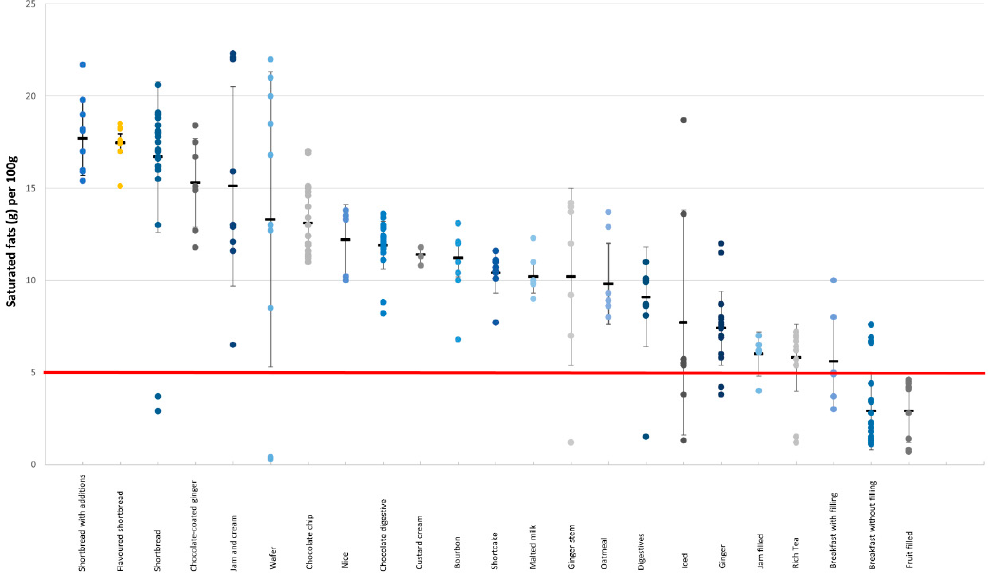
Figure 5. Saturated fat content (g/100 g) in different categories of biscuits. The red line denotes the high criteria for saturated fat.